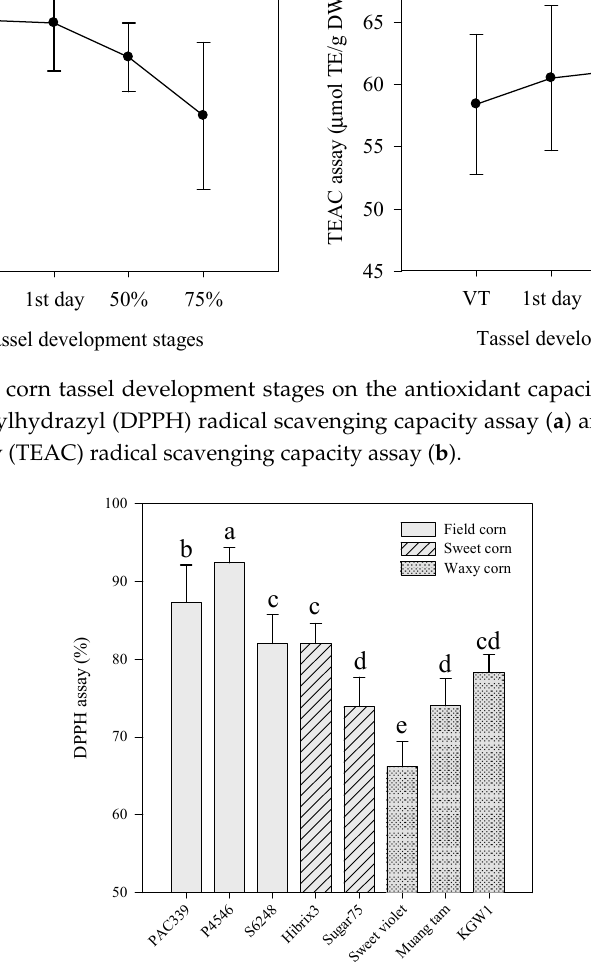
Table 6. Means for the TEAC radical scavenging capacity in the tassels of eight corn varieties evaluated at four tassel development stages . Varieties